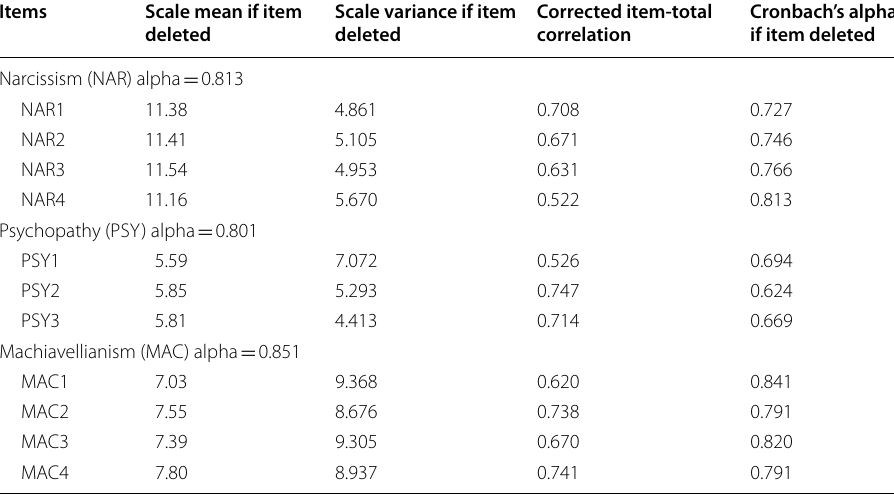
Source: SPSS analysis